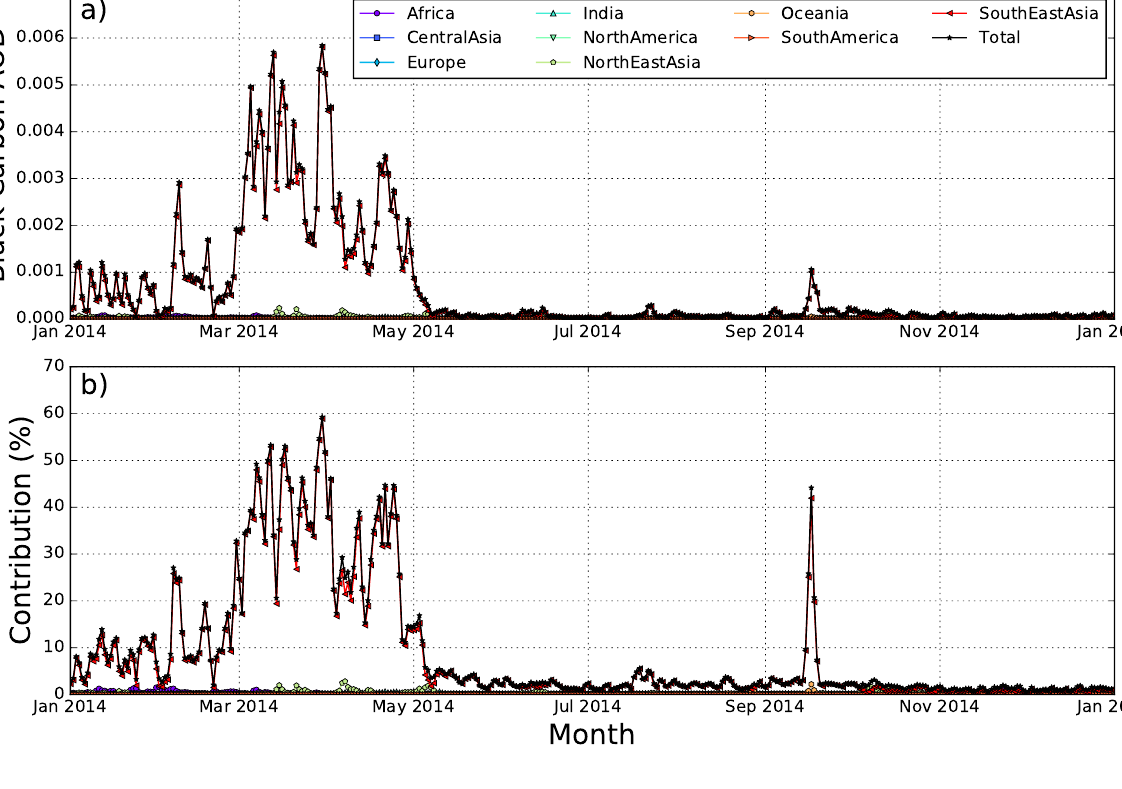
Figure 6. The absolute contribution of biomass burning black carbon AODs from different source regions (a) and their relative contribution to the total black carbon AODs (b) over Hong